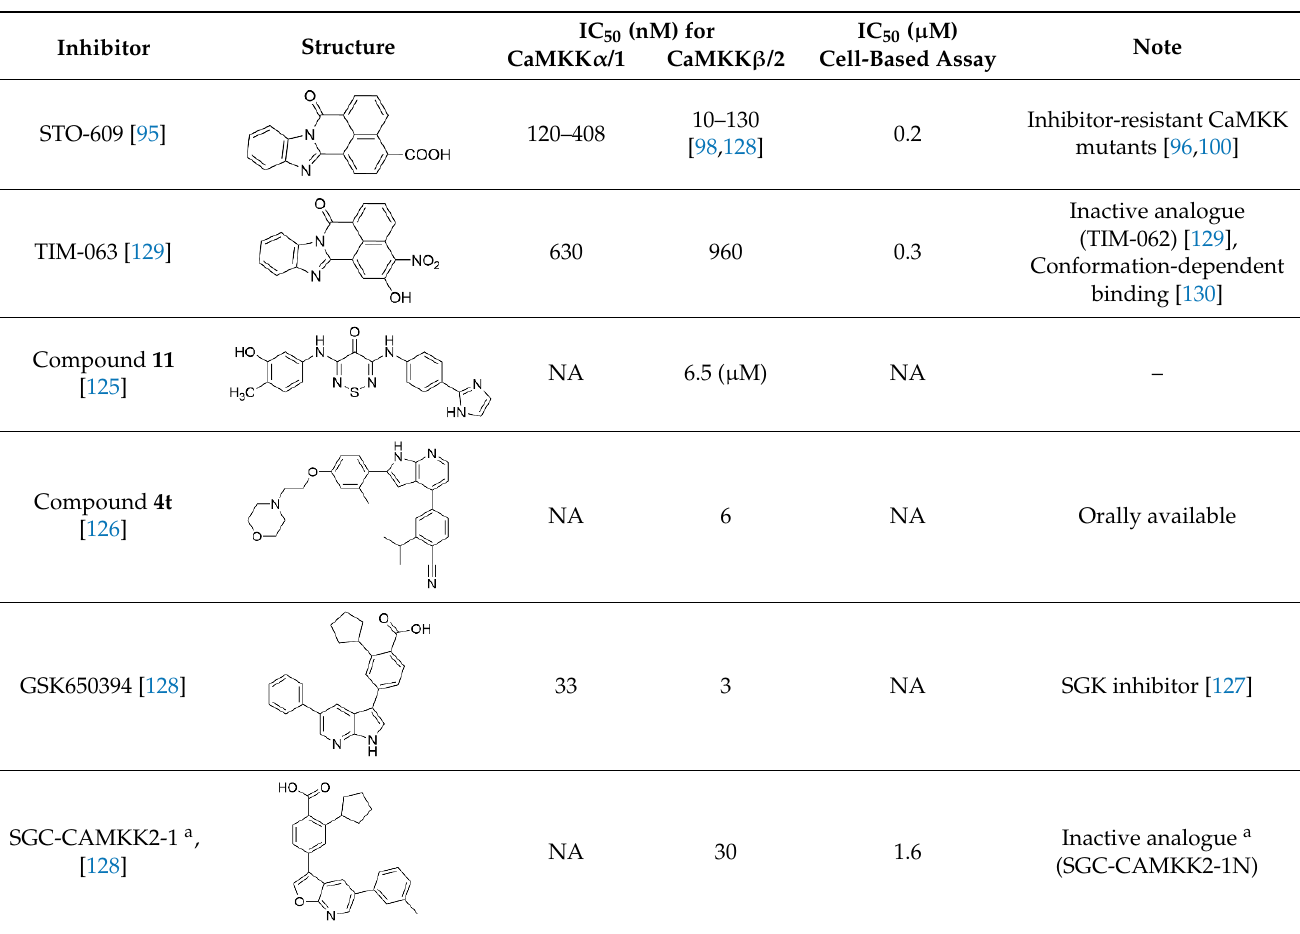
Table 2. CaMKK inhibitors.